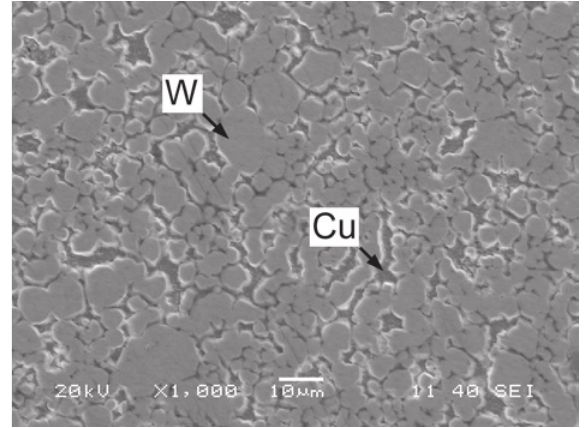
Fig. 1: Microstructure of W-Cu composite